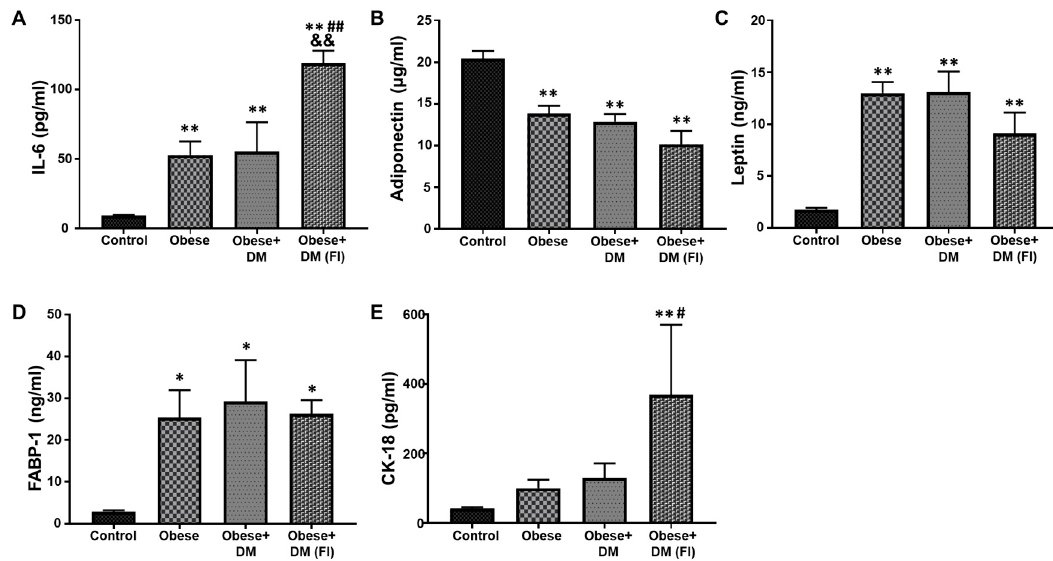
Figure 1. Quantitative analysis of plasma biomarkers. ELISA assay was performed to determine concentration of key plasma biomarkers in the patient population, which showed progressively altered levels under diseased condition. Plasma concentrations of: ( A ) IL-6; ( B ) adiponectin; ( C ) leptin; ( D ) FABP-1; and ( E ) CK-18. Control (n = 20), Obese (n = 20), Obese + DM (n = 12) and Obese + DM(FI) (n = 10). Values represent means ± SEM. * p < 0.05, ** p < 0.01 vs. Control; # p < 0.05, ## p < 0.01 vs. Obese, && p < 0.01 vs. Obese + DM.